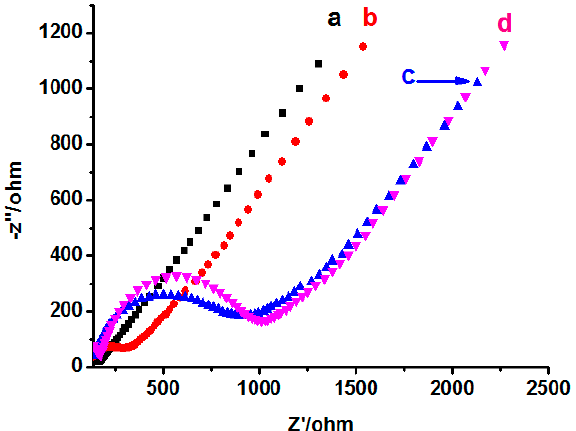
Figure 6. EIS of different electrodes (( a ) bared electrode; ( b ) INS after elution; ( c ) NINS after elution; and ( d ) INS before elution).